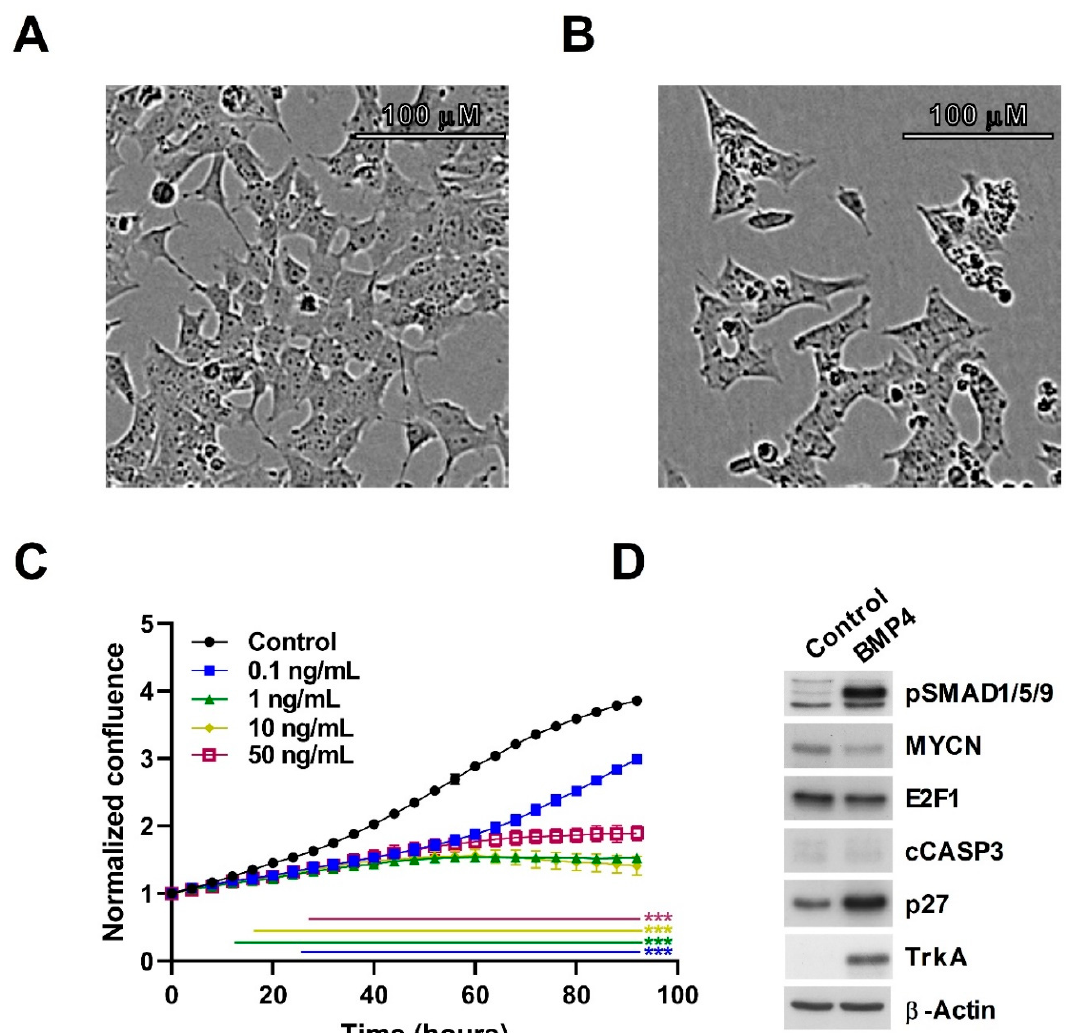
Figure 2. BMP4 treatment induces growth inhibition in SK-N-BE(2)-C cells. ( A ) Phase contrast image of vehicle-treated SK-N-BE(2)-C cells, and ( B ) 10 ng/mL BMP4-treated SK-N-BE(2)-C cells after 96 hours. ( C ) Cell confluence was measured and analysed in triplicates by Incucyte live cell imaging and was used as a surrogate for growth. Normalized confluence was significantly ( p < 0.01) reduced by BMP4 in all concentrations tested by 30 hours after treatment, based on analysis of triplicate treatments. This experiment is a representative of 3 biological replicates ( n = 3). ( D ) Western blot of changes in protein expression and phosphorylation after 96 hours of BMP4 treatment. Quantification of Western blot data is shown in Supplementary Figure S1A.